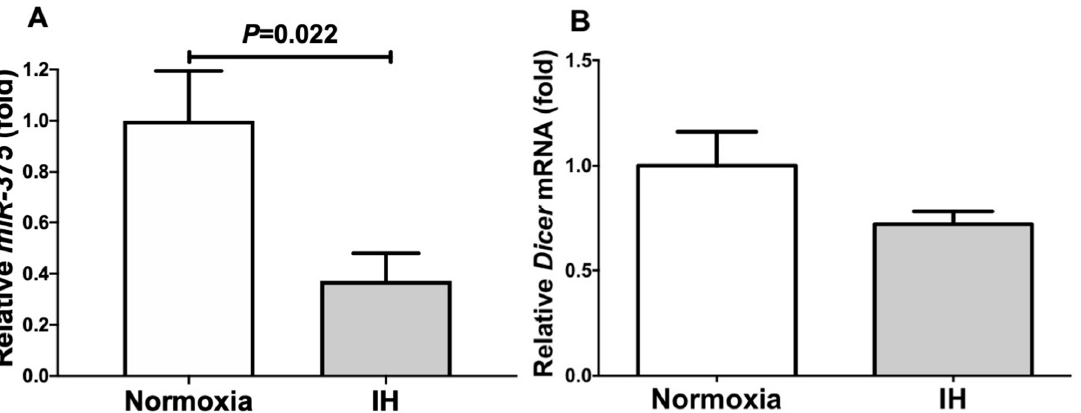
Figure 6. The levels of miR-375 ( A ) and Dicer mRNA ( B ) in human NB-1 cells subjected to